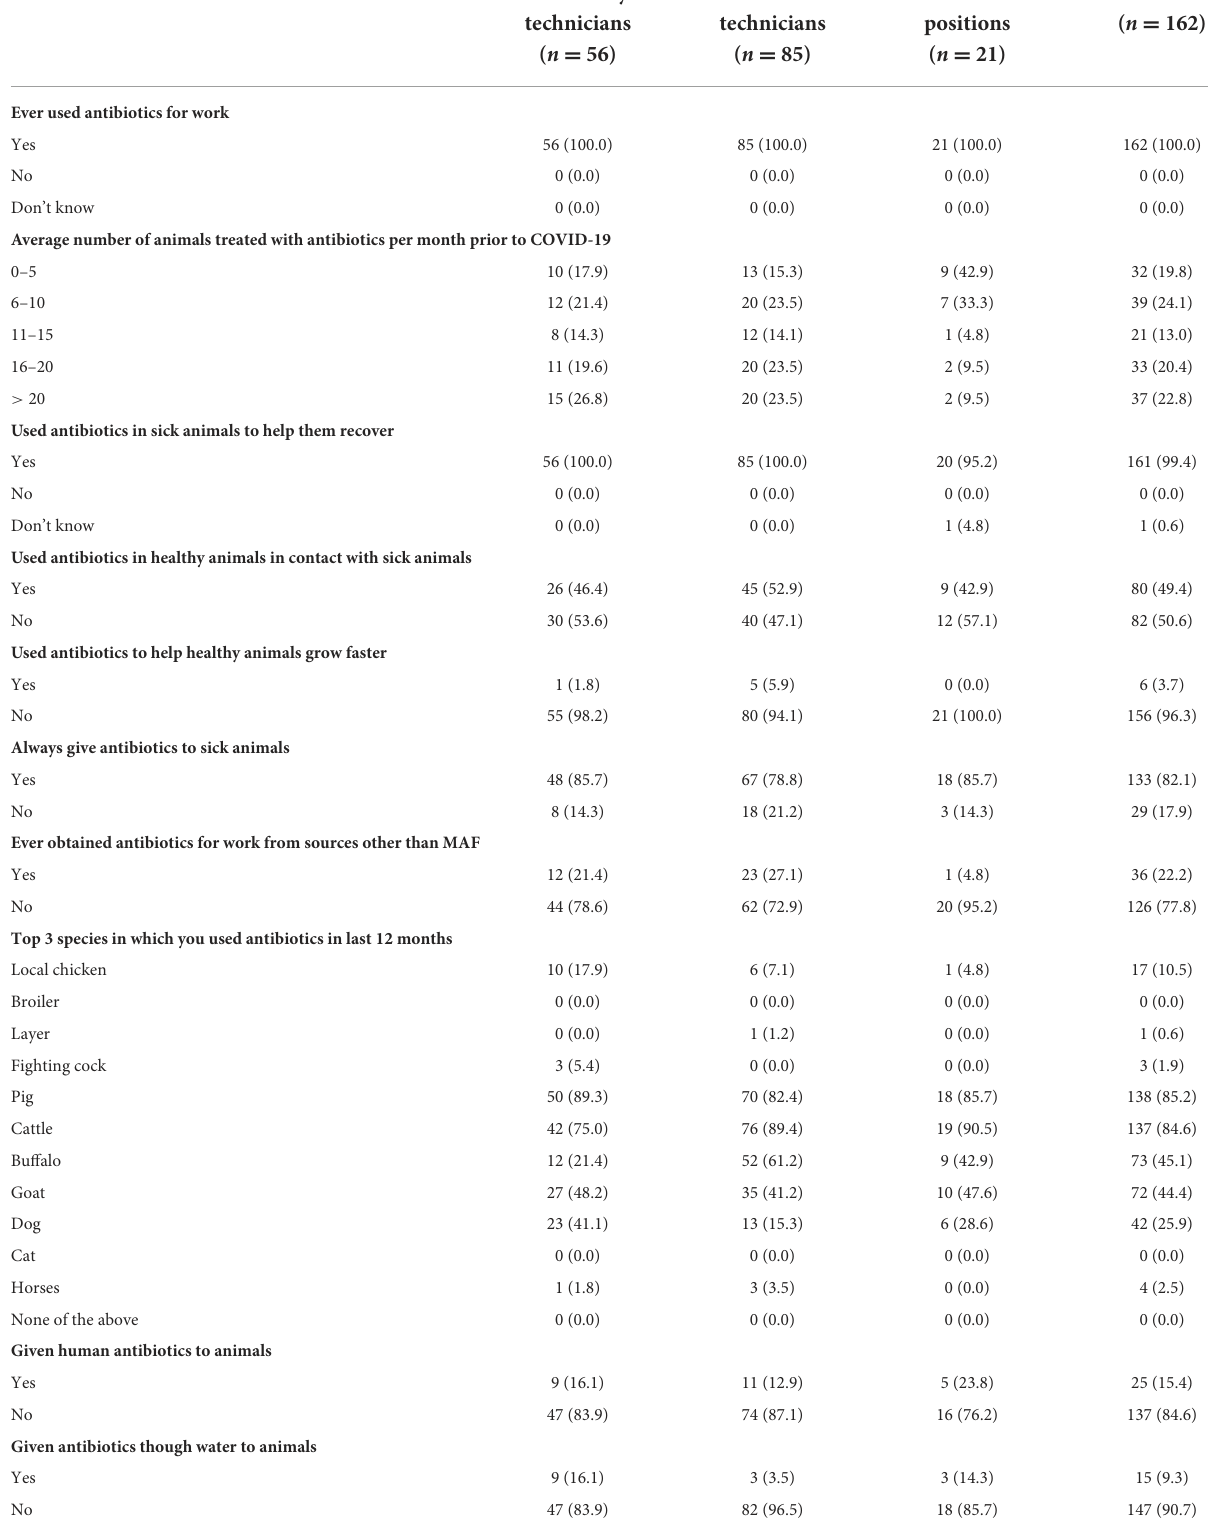
TABLE 4 Antibiotic use practices (overall and by position) of government animal health workers.